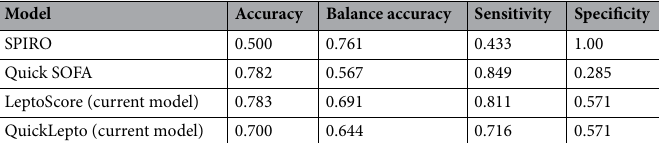
Table 3. Comparison of accuracy metrics with the previous predictive